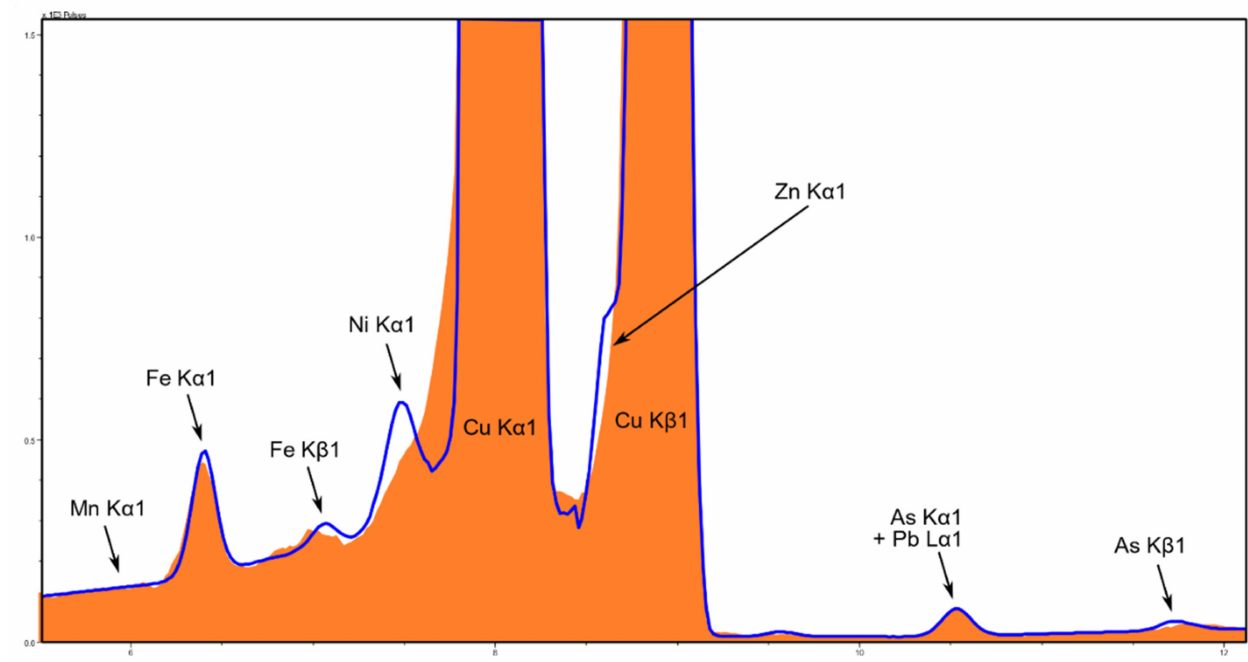
Figure A2. Spectrum of a typical bronze piece, showing the Cu K α peak overlap on Ni and the Cu K β overlap Zn. The spectrum is shown in orange and the fitted peaks (using Bruker’s Artax v.8.0 software) as a blue